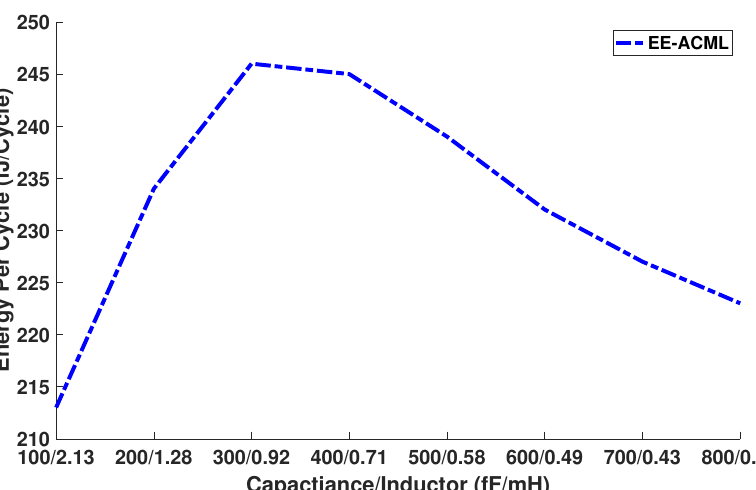
Figure 15. Effect of different inductor and capacitor values on energy consumption.